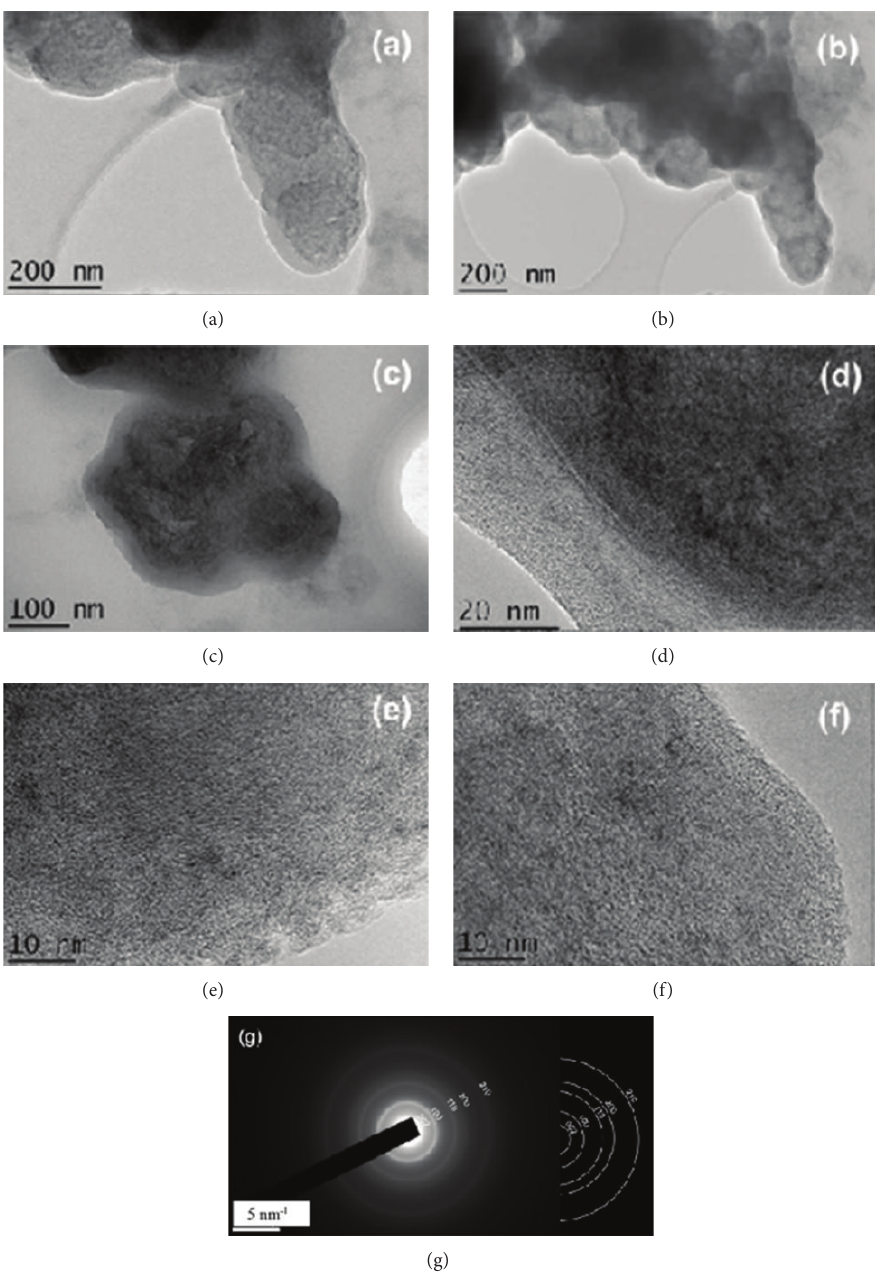
Figure 5: TEM micrographs of selected particles ((a)–(f)) and electron diffraction pattern (g).